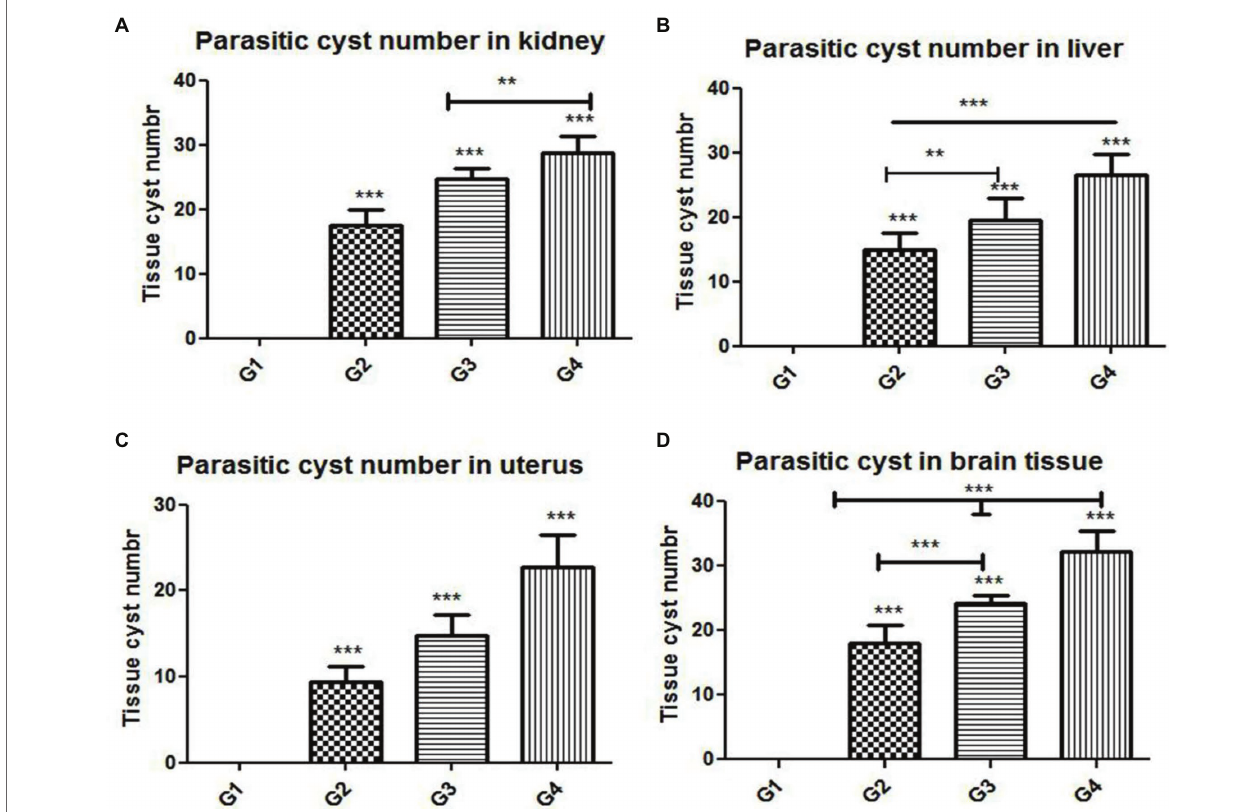
FIGURE 8 | Histomorphometry graph showing quantitative measurements of parasitic cyst in (A) kidney, (B) liver, (C) uterus, and (D) brain tissue among the experimental groups. Data are expressed as means ± standard deviations. Significant differences vs. the control group are marked by different asterisks through one-way ANOVA with Tukey’s post-hoc test: ** p ≤ 0.01, *** p ≤ 0.001.